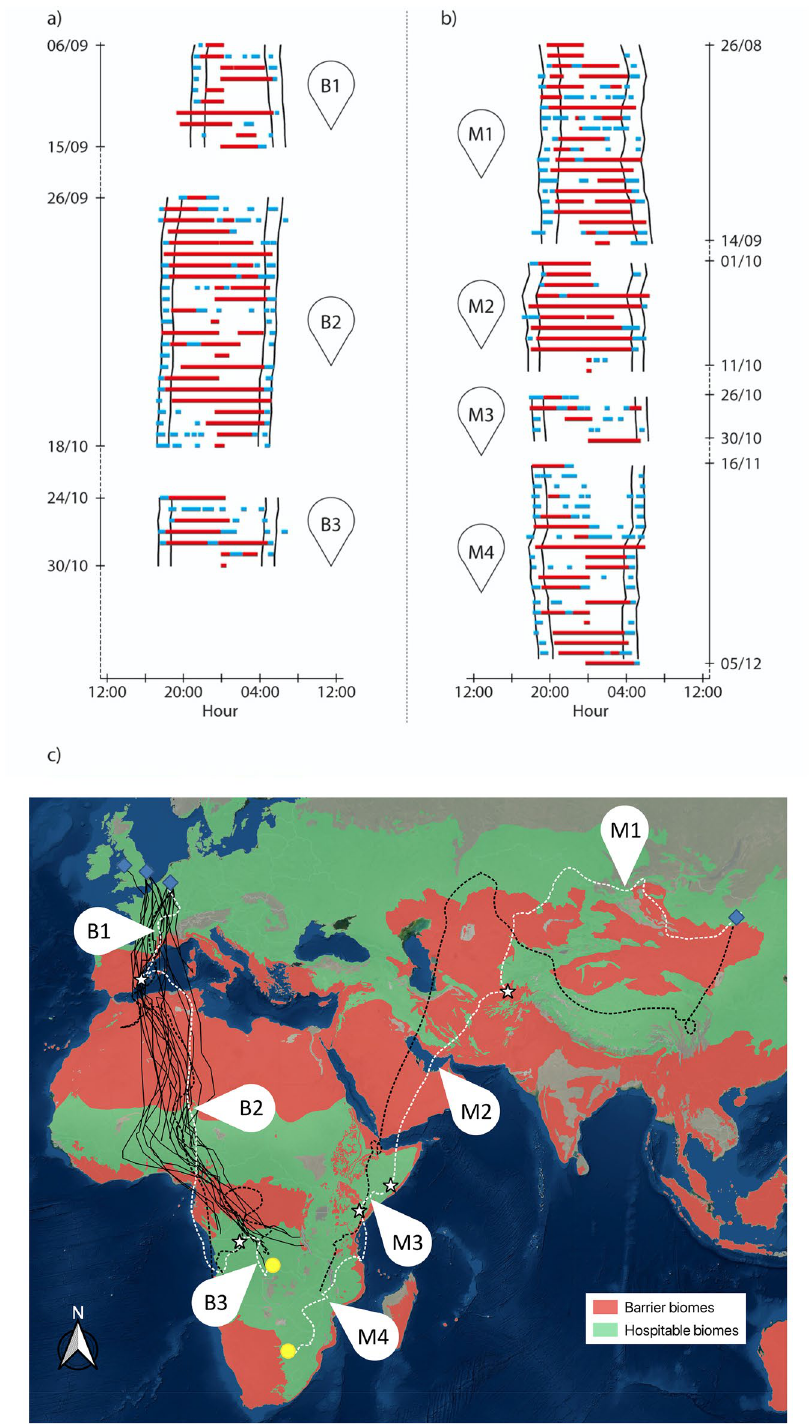
Figure 1. Actograms ( a , b ) and migration routes ( c ) of European Nightjars breeding in Belgium ( a ) and in Mongolia ( b ). Example of actograms from two individuals showing daily activity (red = migratory flight, blue = foraging activity, white = no/low activity, measured per five-min period) covering migration segments (Belgian individual: B1-3, Mongolian individual: M1-4) from dusk until dawn. Each horizontal bar shows one day with time on the X-axis. Time is plotted in eight-hour intervals and centred around local midnight. Black lines show the timing of sunset at the estimated location of each individual. Stopover periods are not shown on the actograms. The bottom map ( c ) shows the categorized biomes [barriers (red), hospitable (green); adapted from 37 ] with geolocator tracks (dotted lines) and GPS-tracks (full lines). White dotted lines show the migration routes of one Belgian individual (represented in actogram a ) and one Mongolian individual (represented in actogram b ). White stars indicate stopover areas (> 3 days), blue diamonds represent breeding areas and yellow circles represent wintering